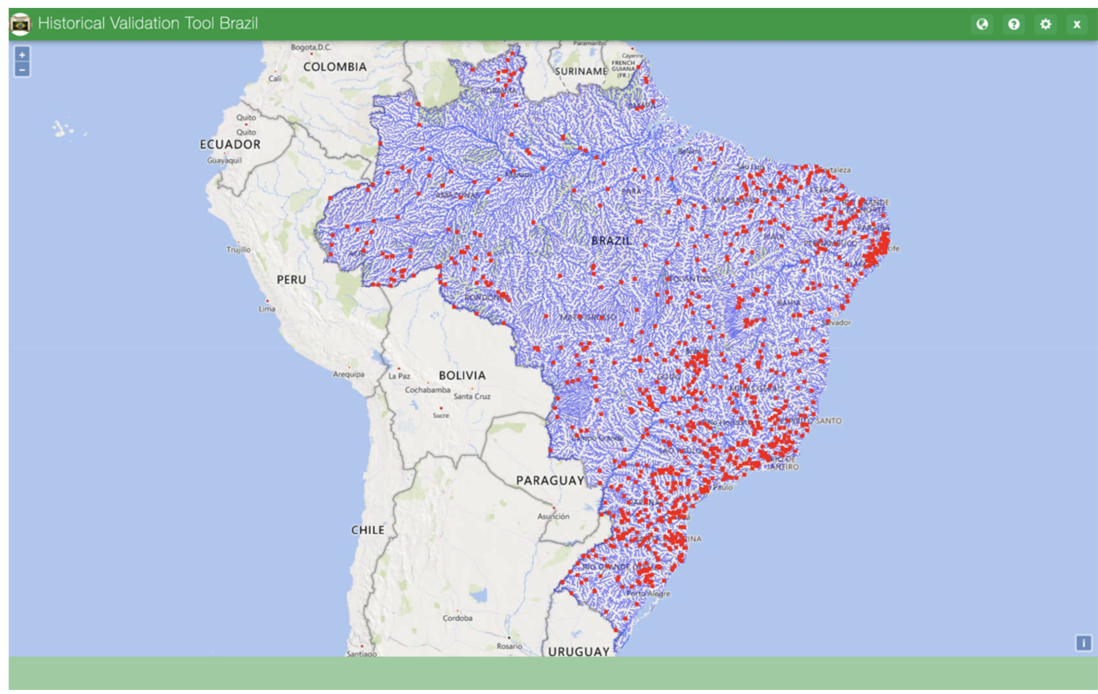
Figure 5. Main page for the historical validation tool app for